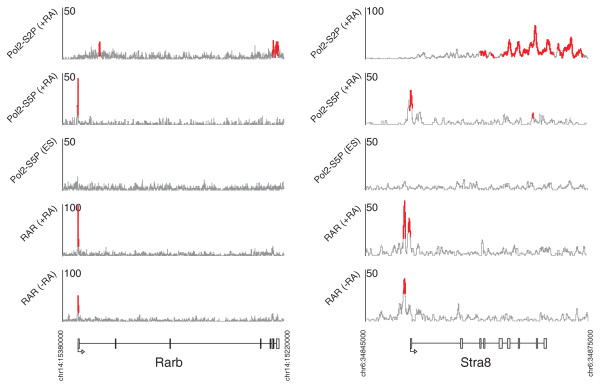
Constitutive RAR binding without ES cell-poised Pol2 at Stra8 and Rarb. RAR is constitutively bound at these targets, but no enrichment of poised/initiating polymerase (Pol2-S5P) is observed in ES cells at these loci. Within 8 hours of retinoid exposure, the initiating and elongating forms of Pol2 are recruited to these genes.